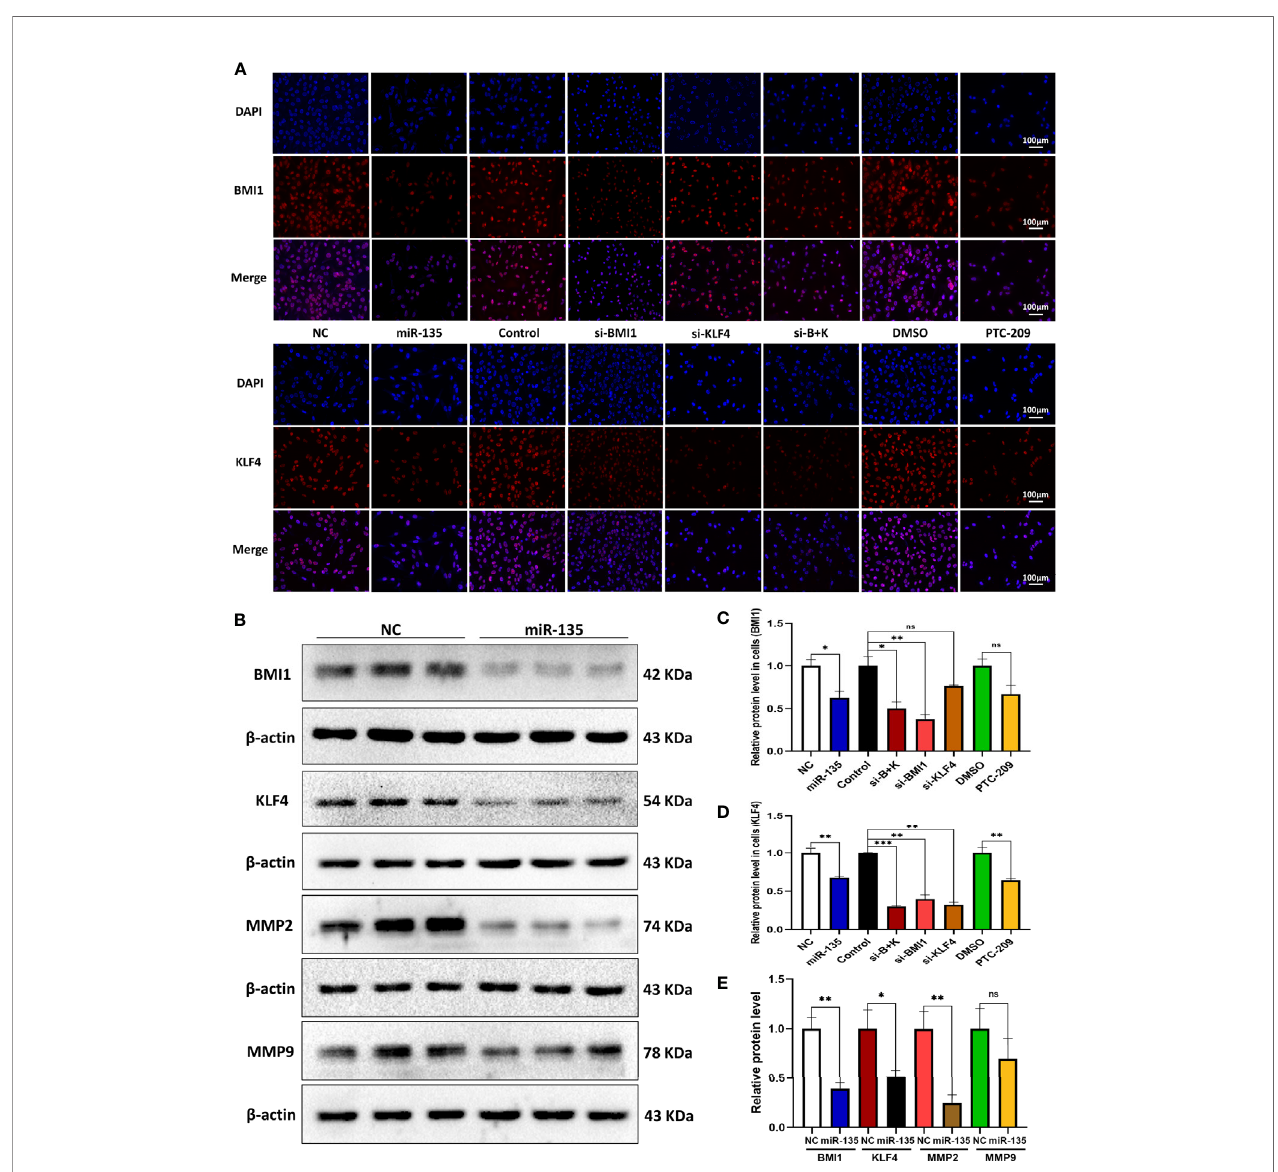
FIGURE 4 | miR-135a, si-BMI1, si-KLF4, combination treatment, and PTC-209 inhibit BMI1 and KLF4 expression in OS cells. (A) Representative pictures from tumor cell immuno fl uorescence assay. The Saos-2 cells with same treatments as above were subjected to the immuno fl uorescence assay. Scale bar, 100 m m. (B) Western blot. Saos-2 cells were grown and transfected with Lv-miR-135a or negative controls and then subjected to the protein extraction and western blot. (C, D) The graphs were the quanti fi ed data of immuno fl uorescence staining of BMI1 and KLF4. (ns p > 0.05; * p < 0.05; ** p < 0.01; n = 3). Quantitation was performed by analyzing the positive cells in relation to DAPI. (E) The graph is the quanti fi ed data of the western blot. (ns p > 0.05; * p < 0.05; ** p < 0.01; n = 3). The data were expressed as the mean ± SEM. NC (Lentivirus negative control), miR-135 (Lentivirus overexpressed miR-135a), Control (siRNA negative control), si-BMI1 (group interfered with siRNA-BMI1), KLF4 (group interfered with siRNA-KLF4), si-B+K (group interfered with siRNA-BMI1 and siRNA-KLF4). ns, not signi fi